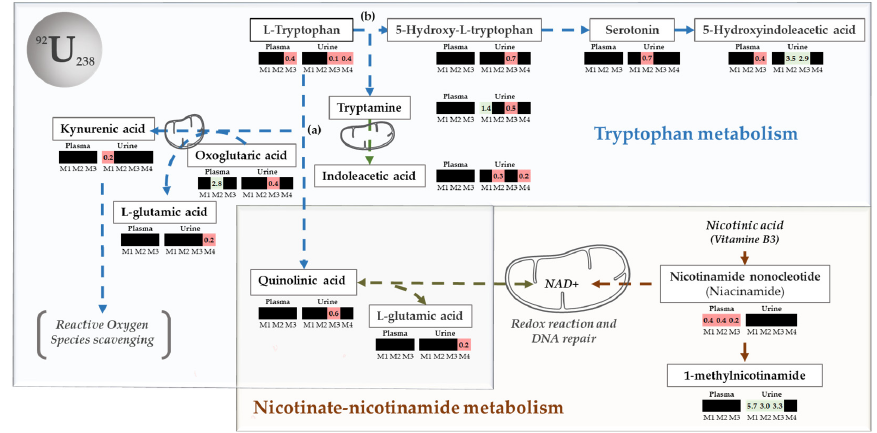
Figure 3. Main pathways targeted by NU at low doses: The main discriminating metabolites identified in urine and plasma are in white boxes. They show that tryptophan and nicotinate–nicotinamide metabolism (https://smpdb.ca; 2021) represent the main targets of acute NU exposure: ( a ) the kynure- nine pathway leading to nicotinate–nicotinamide metabolism and NAD+ synthesis and ( b ) the serotonin pathway are both highlighted by the metabolomic analysis of urine and plasma samples collected at dif- ferent times following the exposure of rats. The heat maps associated with each discriminating metabolite show both their relative levels change (green decrease and red increase) and the corresponding time for it was identified as the most discriminating (black if not significantly